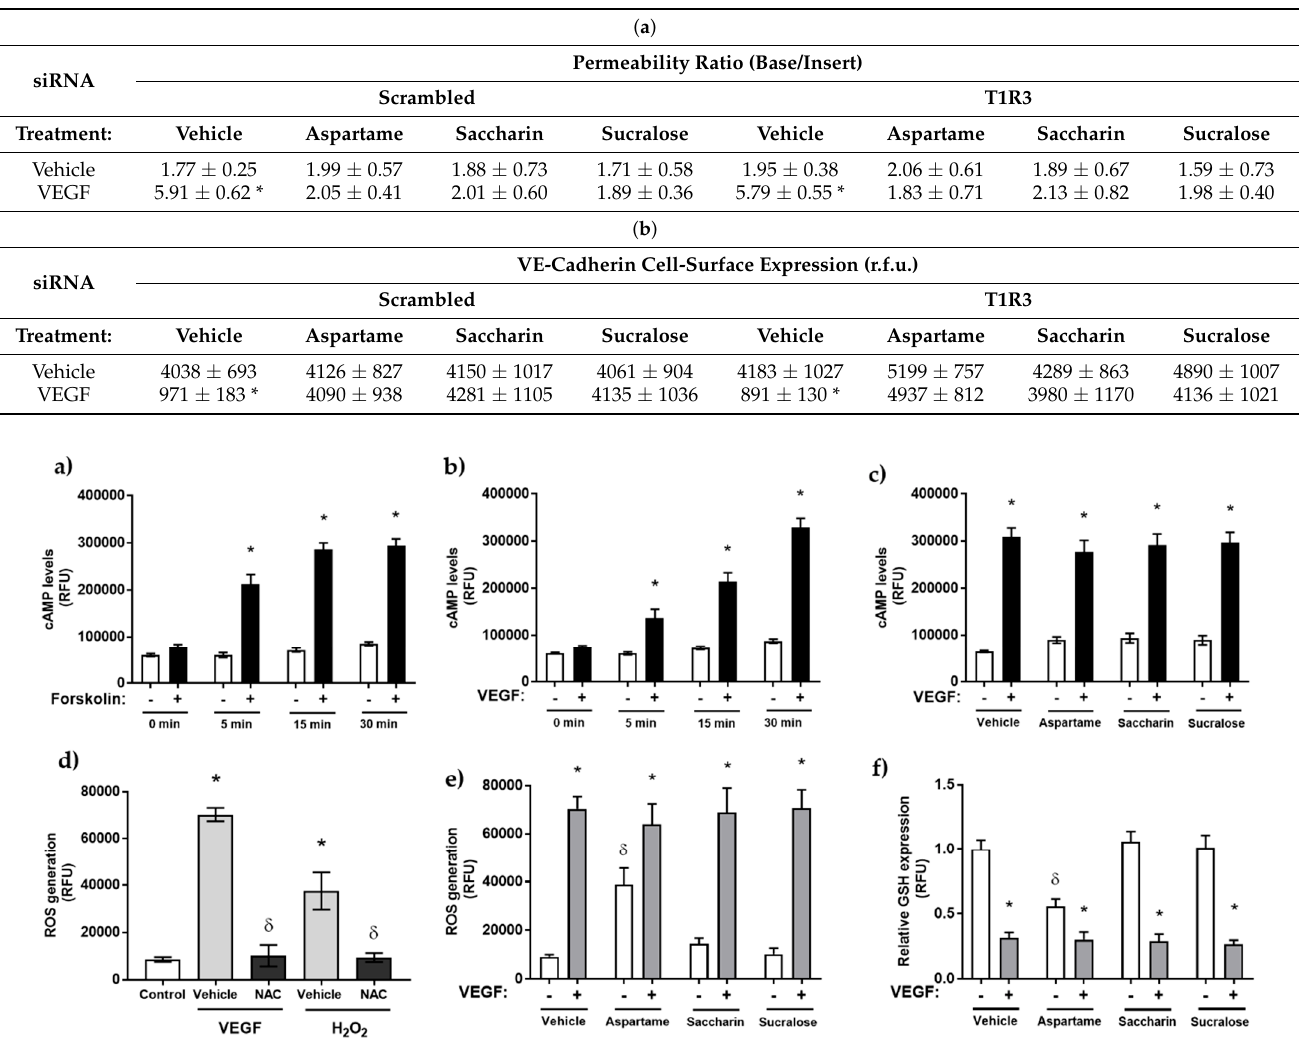
Table 1. Molecular inhibition of T1R3 with siRNA has no impact on sweetener-induced protection against VEGF-induced barrier leak across the glomerular microvascular endothelial cell. GMVEC were transiently transfected with T1R3 siRNA or non-specific scrambled control siRNA (300 nM) for 24 h followed by exposure to artificial sweeteners aspartame (10 µM), saccharin (0.1 µM), and sucralose (0.1 µM) for 20 h. Cells were then exposed to VEGF (50 ng/mL) for a further 4 h. Permeability was assessed using FITC-dextran assay (panel a), and VE-cadherin cell-surface expression was measured using the whole-cell ELISA (panel b). n = 5–6. Data are expressed as mean with S.E.M * p < 0.05 vs. vehicle for VEGF.